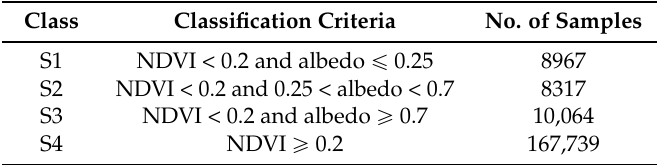
Table 6. Four classifications based on combinations of Normalized Difference Vegetation Index (NDVI) and albedo (see Table 2, with their corresponding numbers of samples. Class Classification Criteria No. of Samples S1 NDVI < 0.2 and albedo ď 0.25